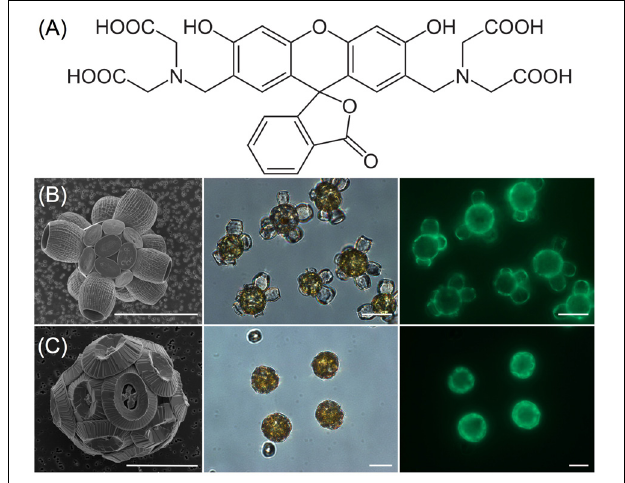
FIGURE 1 | Calcein staining of calcium carbonate coccoliths using epifluorescence. (A) The structure of calcein (Bis[ N , N- bis(carboxymethyl)aminomethyl]fluorescein) with four carboxyl groups that coordinate and bind with Ca 2 + ions, thereby altering fluorescence properties. (B) Scyphosphaera apsteinii , from left to right; SEM, DIC micrograph and corresponding calcein epifluorescence (FITC filterset) image of cells 24 h after calcein staining and washing protocol. (C) Coccolithus braarudii, from left to right; SEM, DIC micrograph, and corresponding calcein epifluorescence image of cells 24 h after calcein staining and washing protocol. Scale bars represent 10 µ